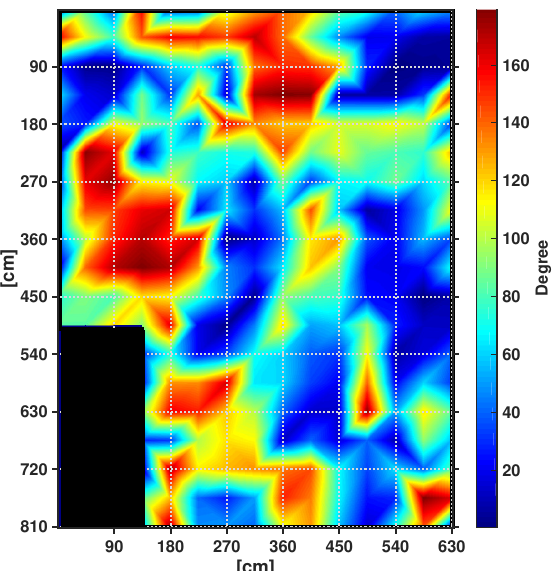
Figure 1. Heading Error Map. Blue color indicates locations with low level of perturbation, while red color represents points highly perturbed. The black color at the bottom left corner identifies a space outside the room.